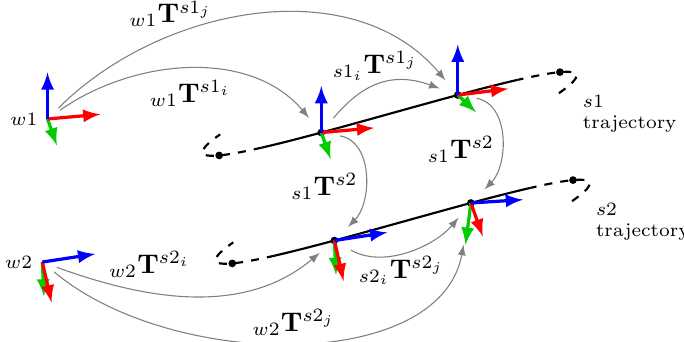
Figure 1. Graphical representation of the motion-based sensor-to-sensor calibration concept, where pose i is used as the reference frame for pose j